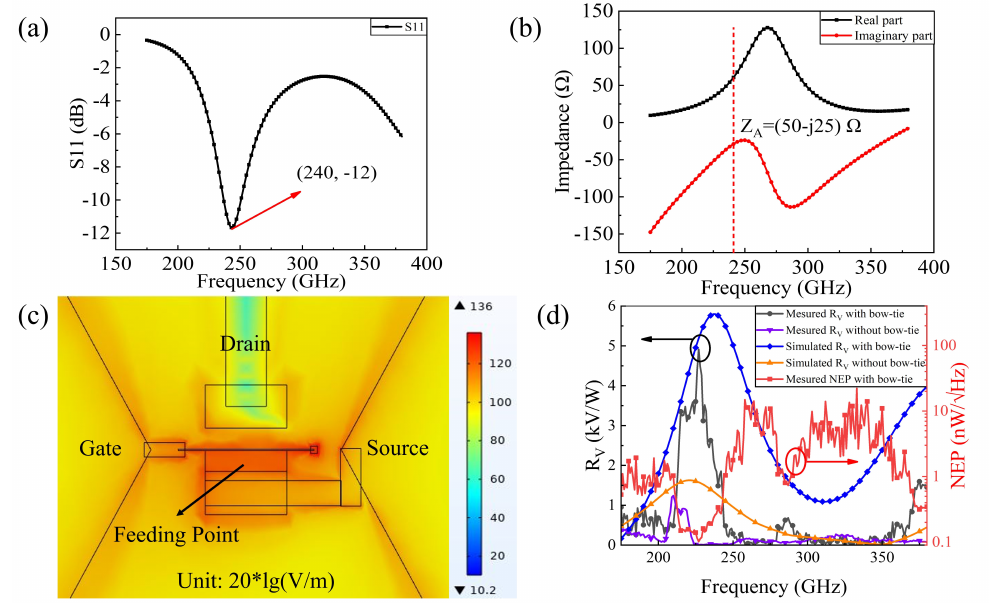
Figure 4. ( a ) The simulated S11 of the structure. ( b ) The simulated impedance of the structure. ( c ) Distribution of the electric field on the surface of the TeraFET detector around the gate (top view). ( d ) Measured and simulated R V with and without a bowtie antenna from 175 to 384 GHz. The red line indicates the measured NEP of the detector with a bowtie antenna. All the results above correspond to sample